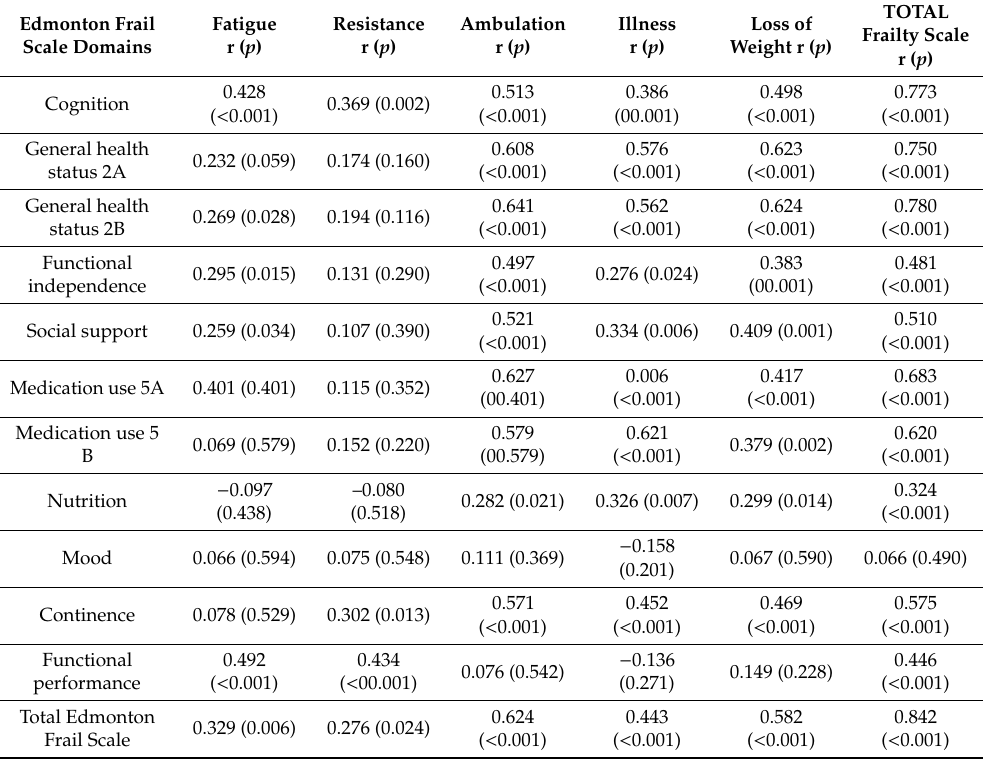
Table 4. Spearman’s correlations between the 5-Frailty scale and Edmonton Frail Scale score domains and